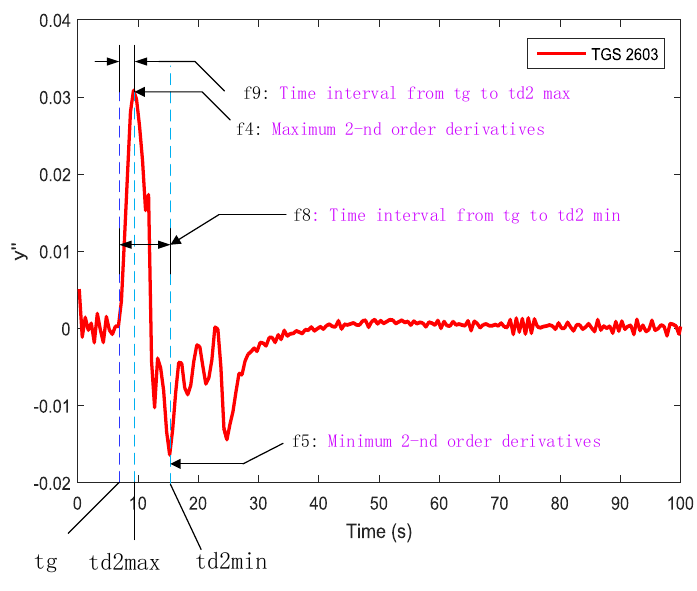
Figure 5. Feature 4, 5, 8, and 9 extracted from 2nd-order derivative-based sensor response